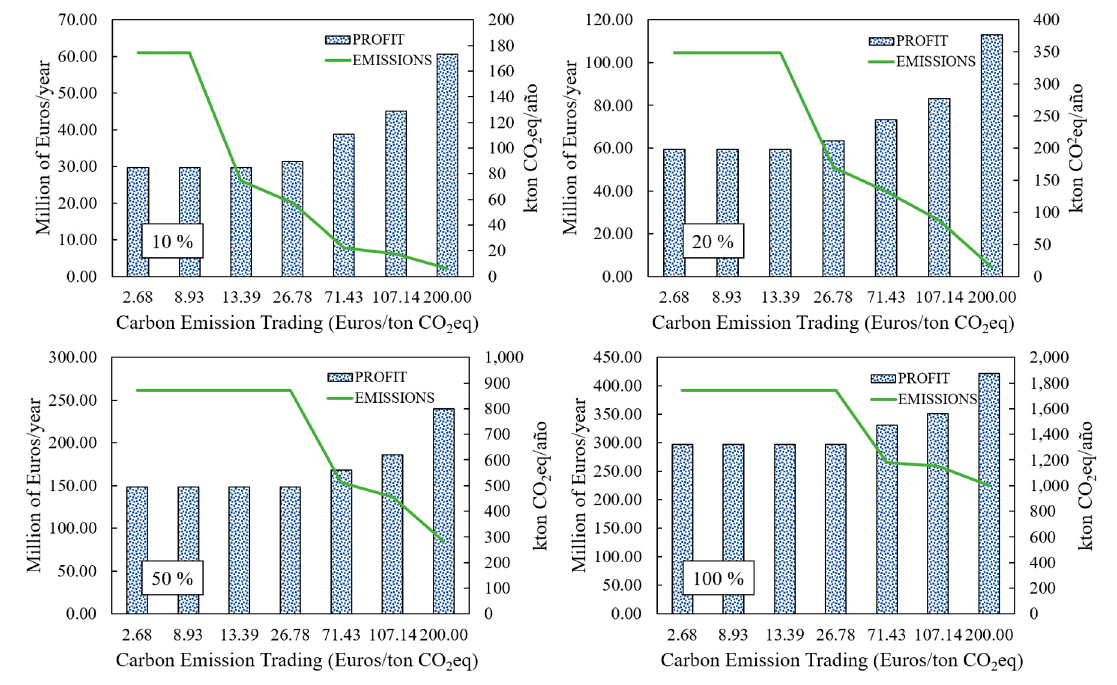
Figure 7. Results for carbon-emission trading using the scenarios from Table 2 to satisfy 10%, 20%, 50% and 100% of energy demand (Case 2).